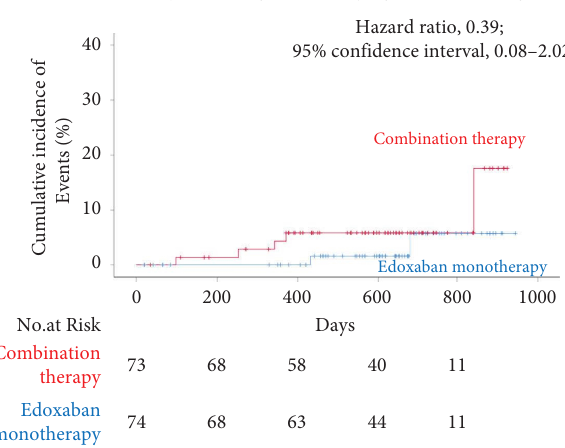
Figure 2: Kaplan–Meier curves for the cumulative incidence of the primary endpoint (occurrence of major bleeding or clinically signifcant bleeding) in the edoxaban monotherapy group and combination therapy